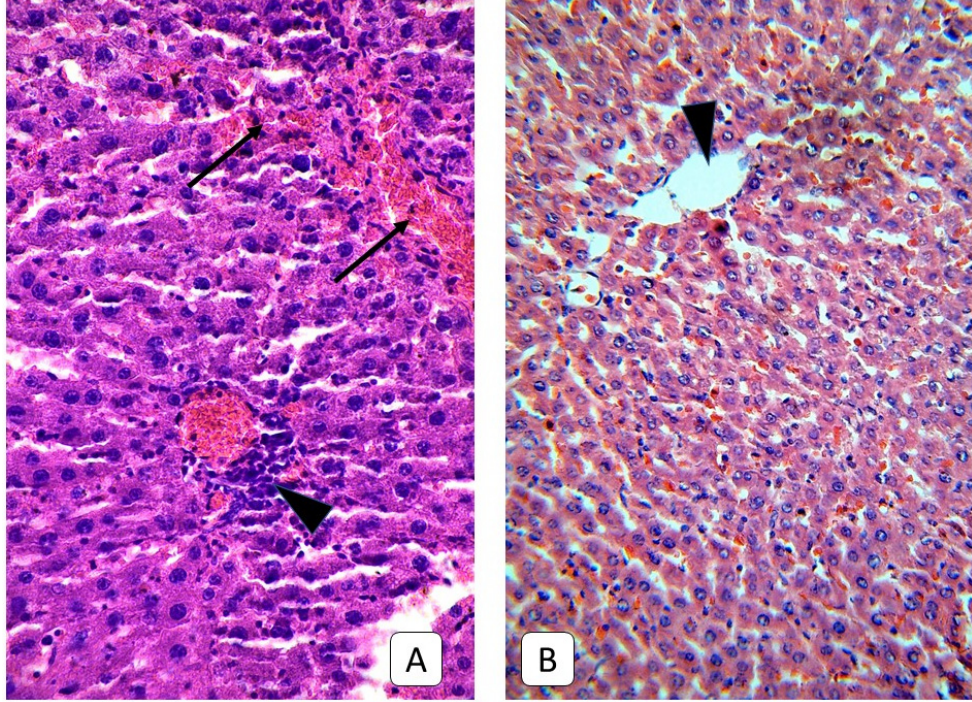
Figure 6. Photomicrograph of the liver. ( A ): adult rats, 7th day after mTBI. Dilated sinusoidal capillaries with RBC sludges and clots (arrow) and infiltrate near central vein (arrowhead). ( B ): control group. Central vein (arrowhead). H E, ×400.